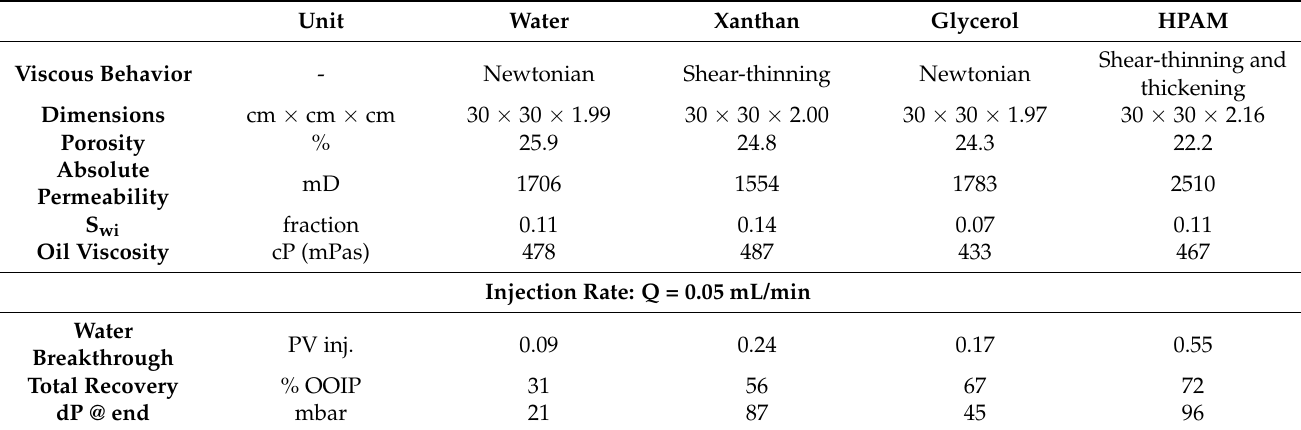
Table 1. Summary of parameters for secondary flood